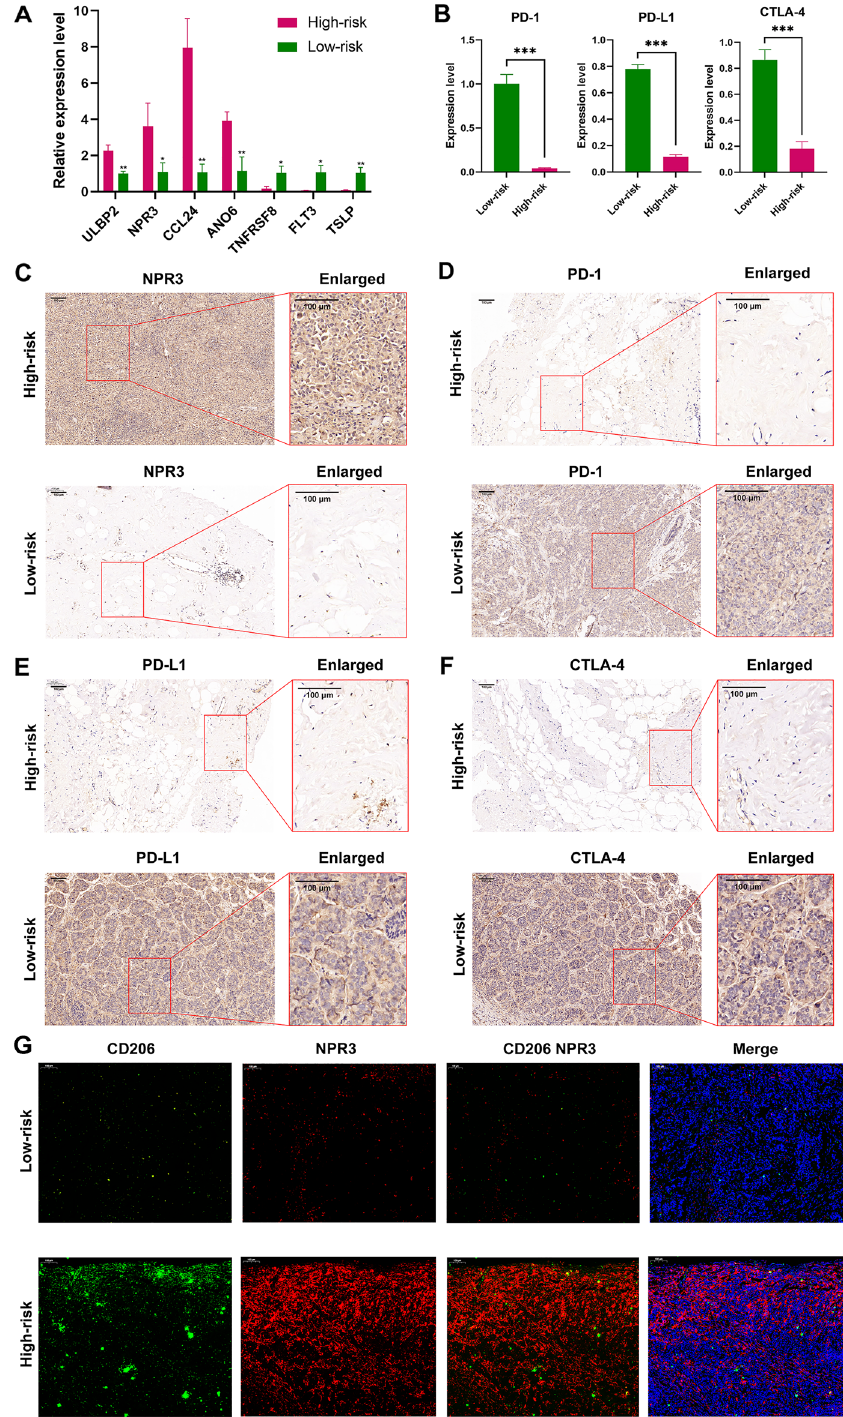
Figure 11. Validation of the predictive ability of the risk model in an external cohort. ( A ) The relative expression of the 7 immune-related genes (IRGs) in breast cancer (BC) samples through quantitative reverse transcription polymerase chain reaction (qRT ‒ PCR) (n = 30). * indicated P < 0.05, ** indicated P < 0.01, P value based on t-test. ( B ) The expression levels of PD-1, PD-L1, and CTLA-4 were decreased in the high-risk group, as evaluated by qRT ‒ PCR (n = 30). *** indicated P < 0.001, P value based on t-test. The immunohistochemistry (IHC) results revealed that the expression of NPR3 ( C ) was increased but that of PD-1 ( D ), PD-L1 ( E ), and CTLA-4 ( F ) was decreased in the high-risk group. ( G ) The immunofluorescence (IF) assay demonstrated that M2 macrophages were more abundant in high-risk patients. IRG immune-related gene, BC breast cancer, qRT ‒ PCR quantitative reverse transcription polymerase chain reaction, IHC immunohistochemistry, IF